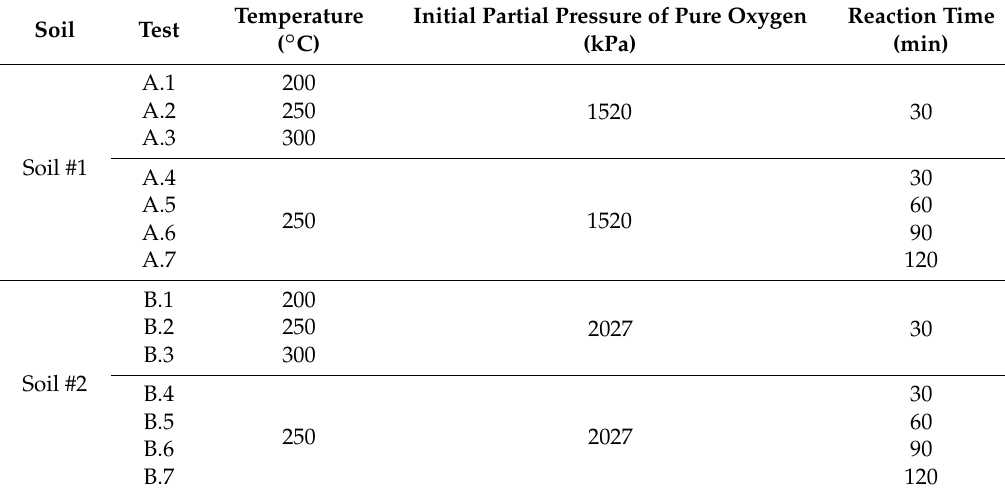
Table 2. Wet oxidation tests performed on the two samples of